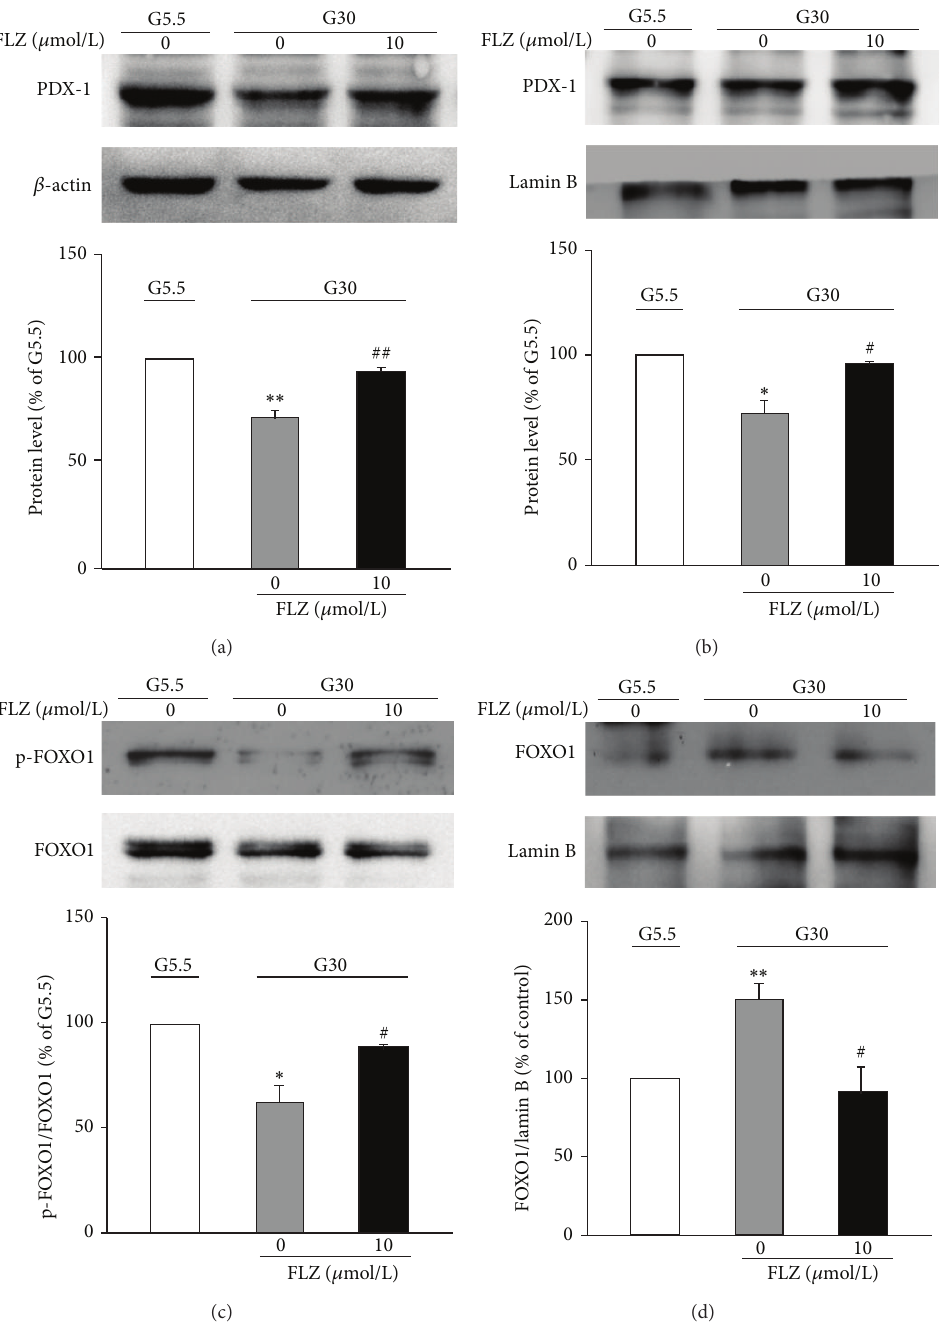
Figure 3: FLZ restores glucotoxicity-altered expression and intracellular localization of PDX-1 and FOXO1. ((a), (c)) INS-1E cells were cultured at G5.5 or G30 for 3 days. Cells were treated without or with 10 𝜇 M FLZ. Expression of PDX-1 (a) or pFOXO1 (c) protein was determined by western blot. 𝛽 -actin was used as an internal control ((a), upper panel). Intensities of PDX-1 (a) or pFOXO1 (c) protein expression were quantified, normalized against the level of 𝛽 -actin (a) or total FOXO1 (c), and expressed as fold of protein abundance in INS-1E cells at G5.5 (low panels). Data are means ± S.E.M. of 3 separate experiments each. ∗∗ 𝑝 < 0.01 versus the value at G5.5; ## 𝑝 < 0.05 versus the value at G30 without FLZ. ((b), (d)) INS-1E cells were cultured at G5.5 or G30 for 3 days. Cells were treated without or with 10 𝜇 M FLZ. Nuclear protein extraction was subjected to western blot analysis. Lamin B was used as an internal control (upper panels). Intensities of PDX-1 (b) or FOXO1 (d) protein expression were quantified, normalized against the level of Lamin B, and expressed as fold of protein abundance in INS-1E cells at G5.5 (low panels). Means ± S.E.M. results of 3 separate experiments each. ∗ 𝑝 < 0.05 , ∗∗ 𝑝 < 0.01 versus the value at G5.5; # 𝑝 < 0.05 versus the value at G30 without